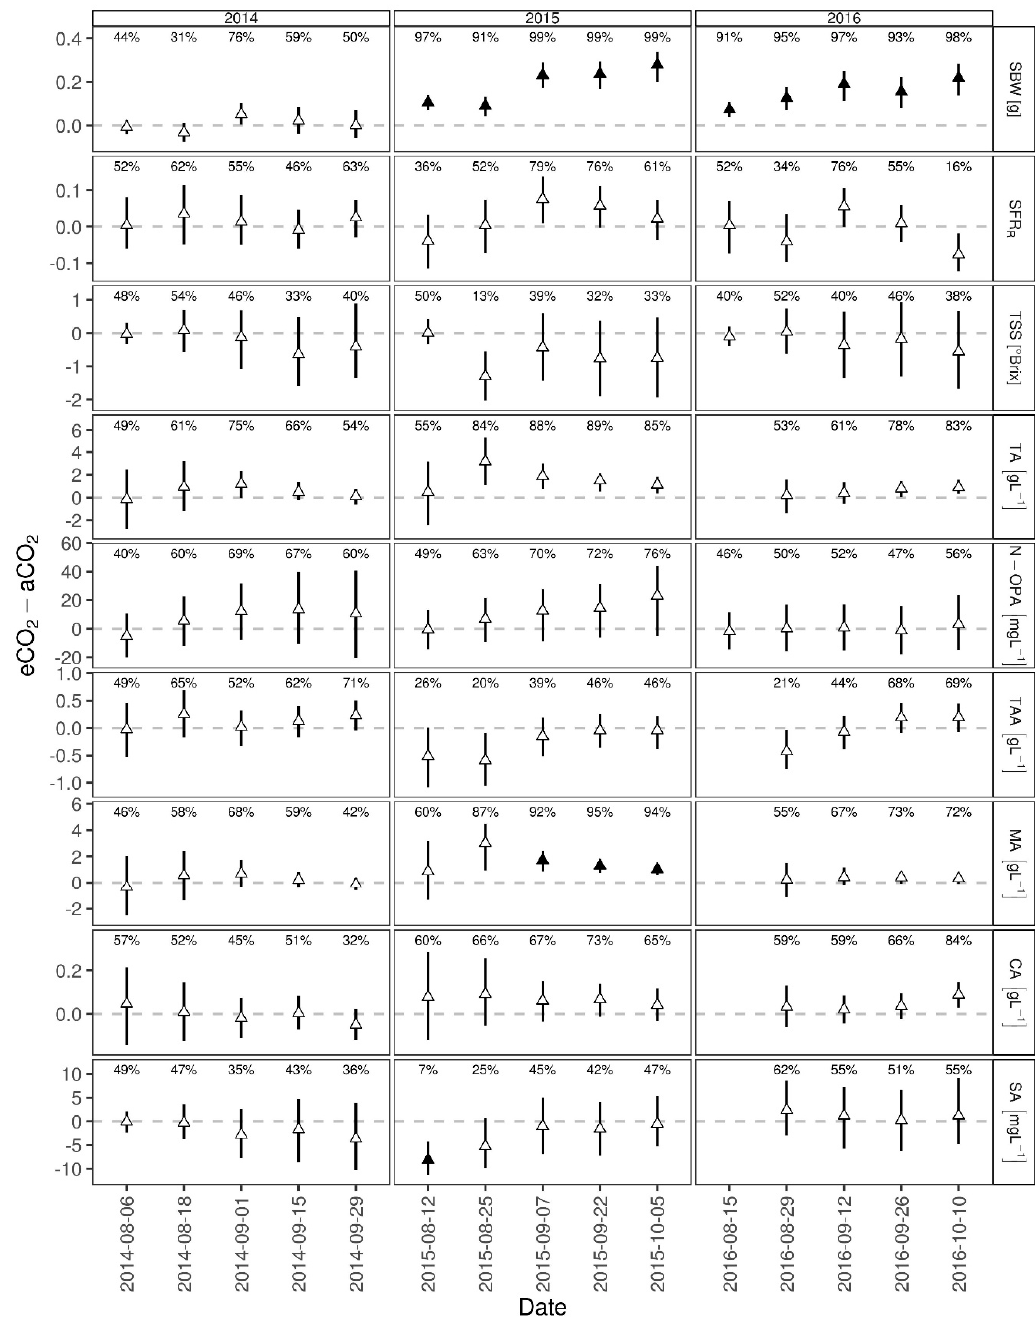
Figure 9. Posterior predicted difference (median and 50% HDI) between eCO 2 and aCO 2 for each measurement date from Bayesian generalized linear mixed effects models on berry quality parameters of Cabernet Sauvignon. Percentages represent the probability of eCO 2 − aCO 2 > 0. Filled symbols indicate “significant differences”, if the probability is >90% (positive difference) or <10% (negative difference).